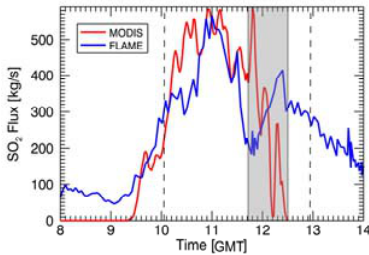
Figure 5: SO 2 Flux comparison. The dashed vertical lines are the event start and end. The grey zone indicates where the MODIS retrieval is carried out on